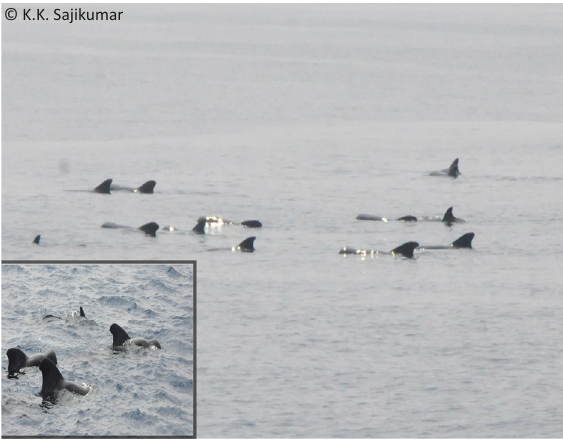
Image 8. Pilot whale pod show resting activity (Logging). Entire pod. (inset) close-up of four